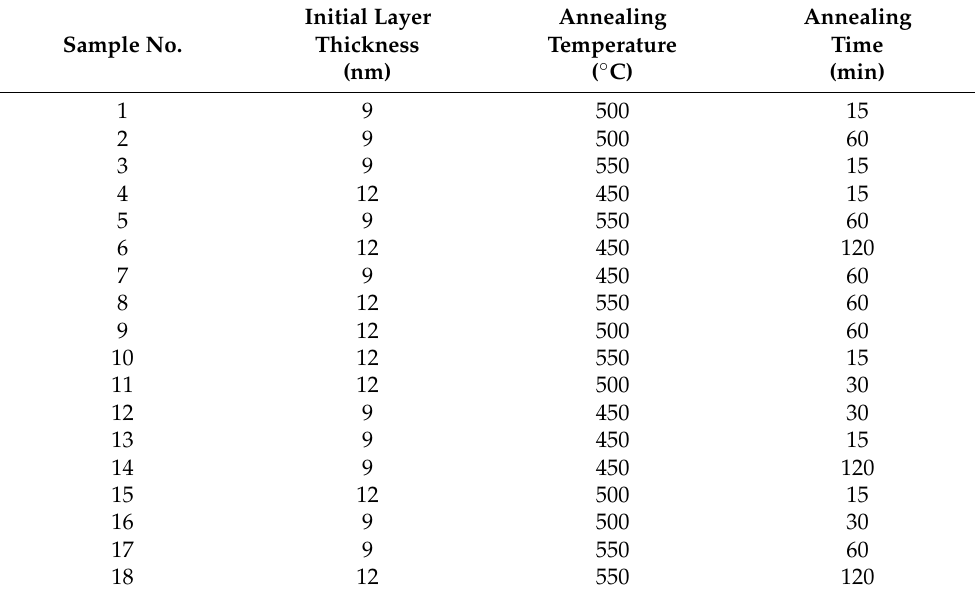
Table 1. Production parameters of gold nanoisland substrates.